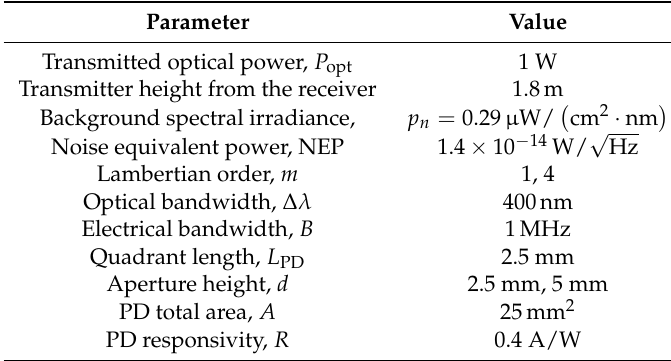
Table 1. Simulation